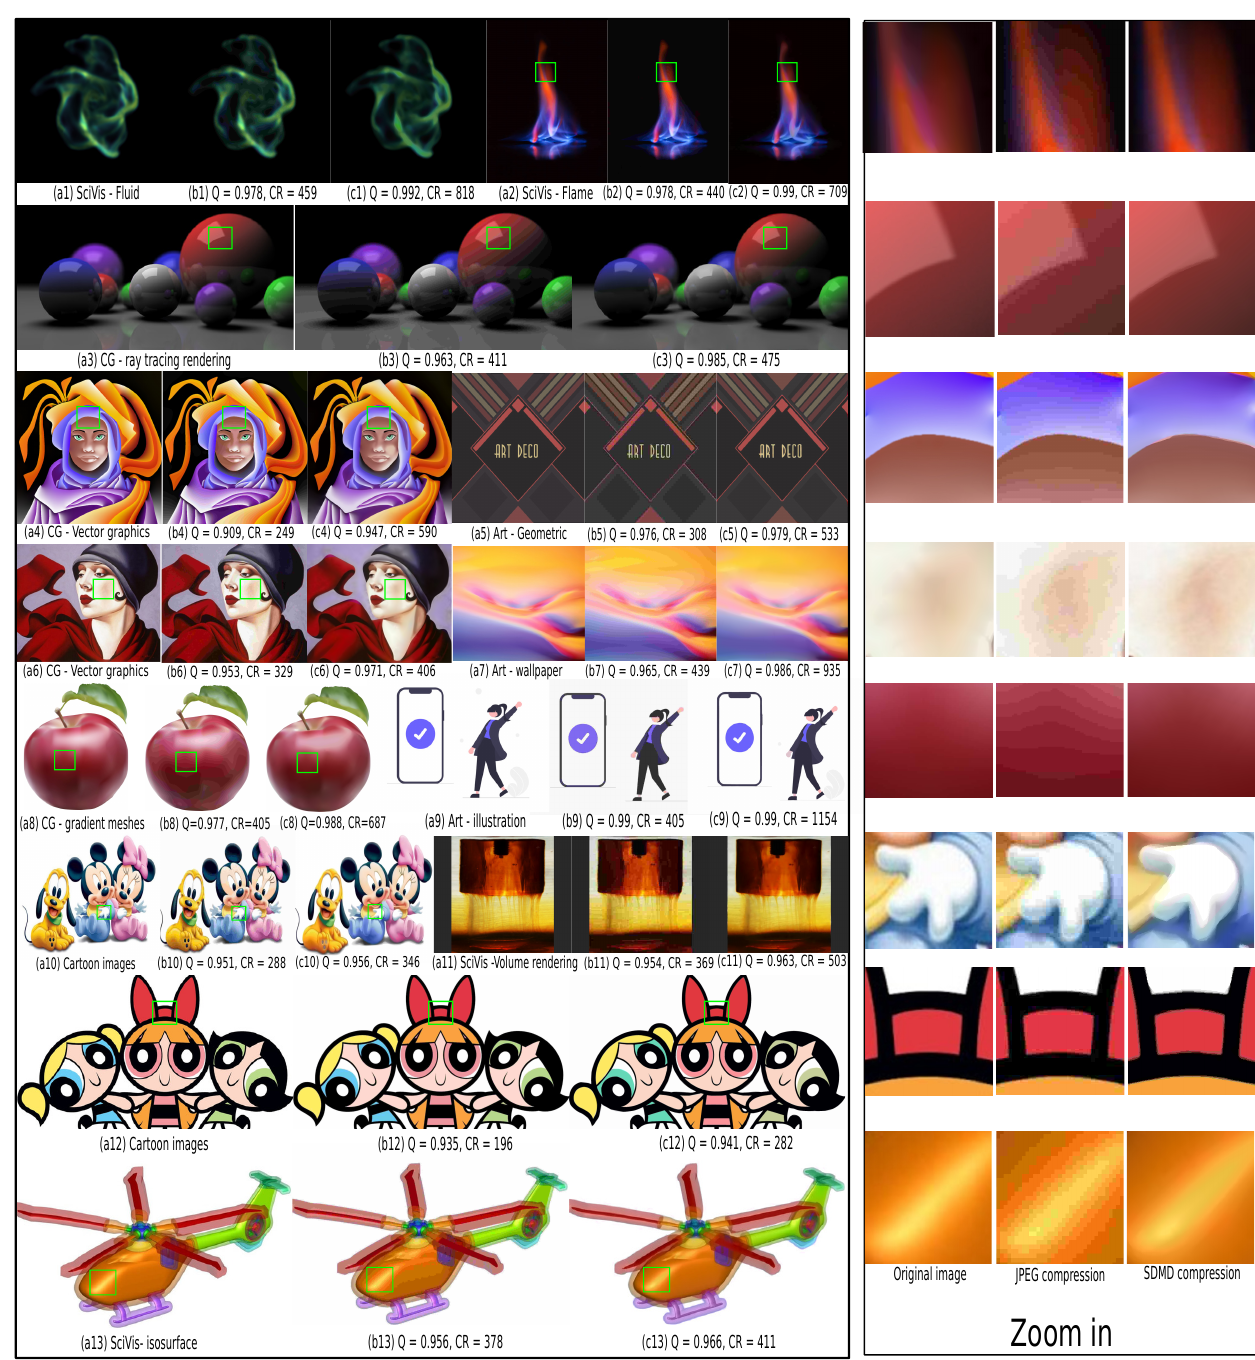
Figure 13. Left pane: Comparison of JPEG for quality set 10% ( b1 – b13 ) with SDMD ( c1 – c13 ) for 13 input images ( a1 – a13 ) which span four types in Table 1. For each result, we show the SSIM quality Q and compression ratio CR. Right pane: For each row, we selected an area of one image to zoom in for detailed